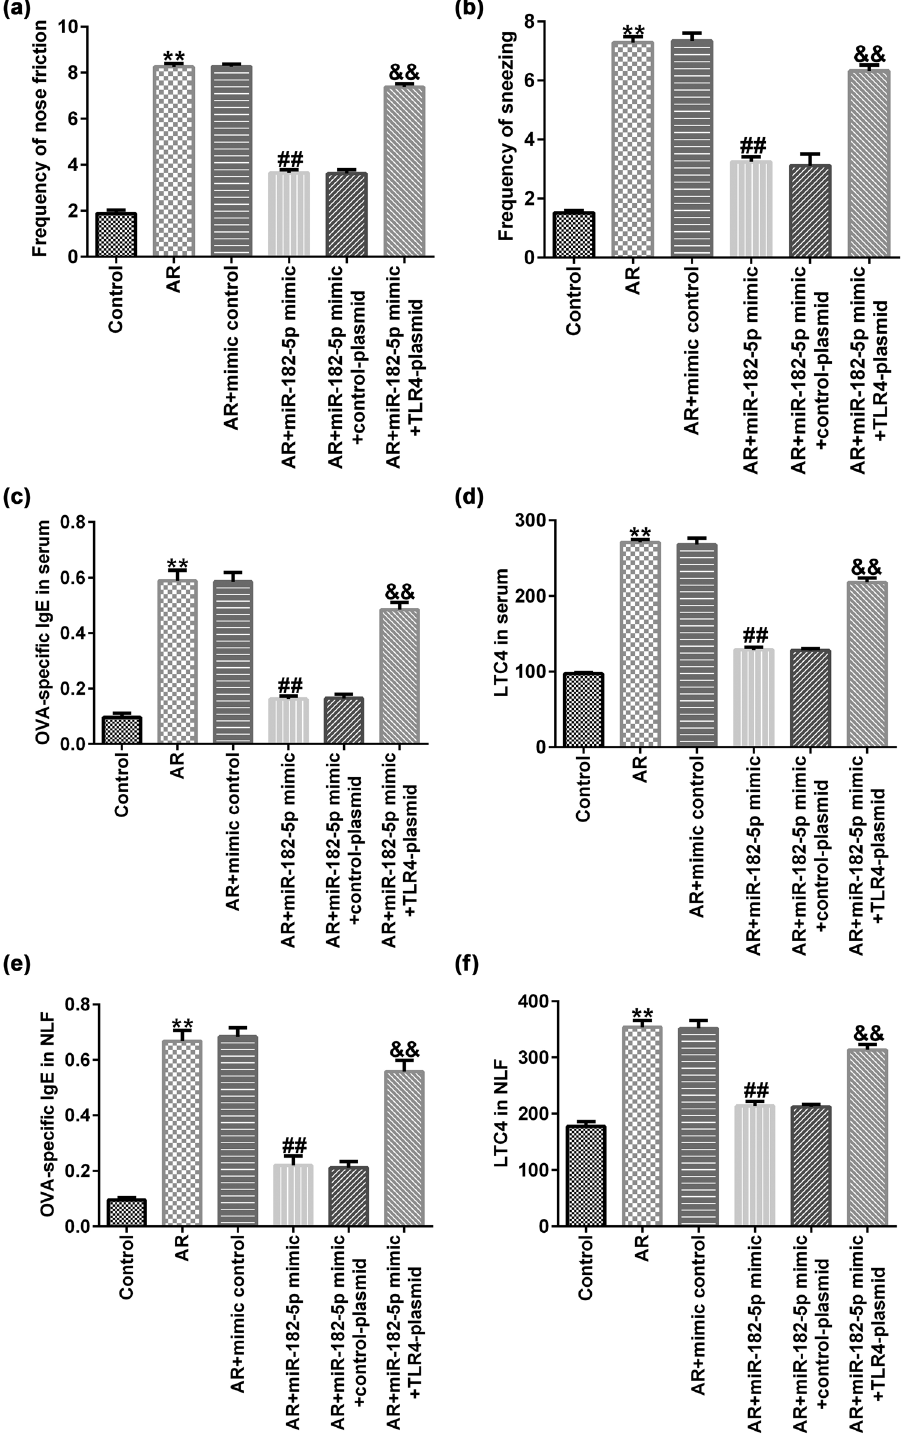
Figure 4: TLR4 reverses the mitigating e ff ect of miR - 182 - 5p on AR mice ( n = 3 ) . ( a ) The frequency of nose rubbing was recorded within 10 min after the last OVA attack on day 34 and the symptom score was calculated as described in the materials and methods section. ( b ) The frequency of sneezing was recorded. ( c and e ) The expression levels of OVA - speci fi c IgE were detected using an ELISA kit. ( d and f ) The expression levels of LTC4 were detected using an ELISA kit. TLR4, toll - like receptor 4; AR, allergic rhinitis; OVA, ovalbumin, IgE, immunoglobulin E, LTC4, leukotriene